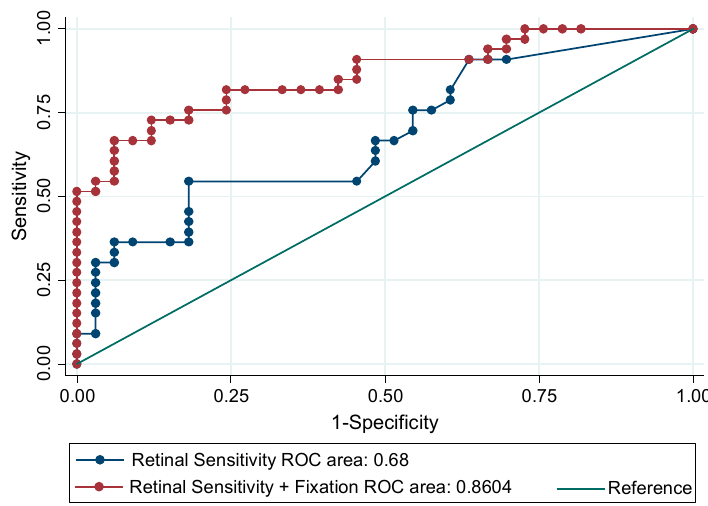
Table 5. Multicollinearity assessment: Variance inflation factor (VIF) for each predictor.